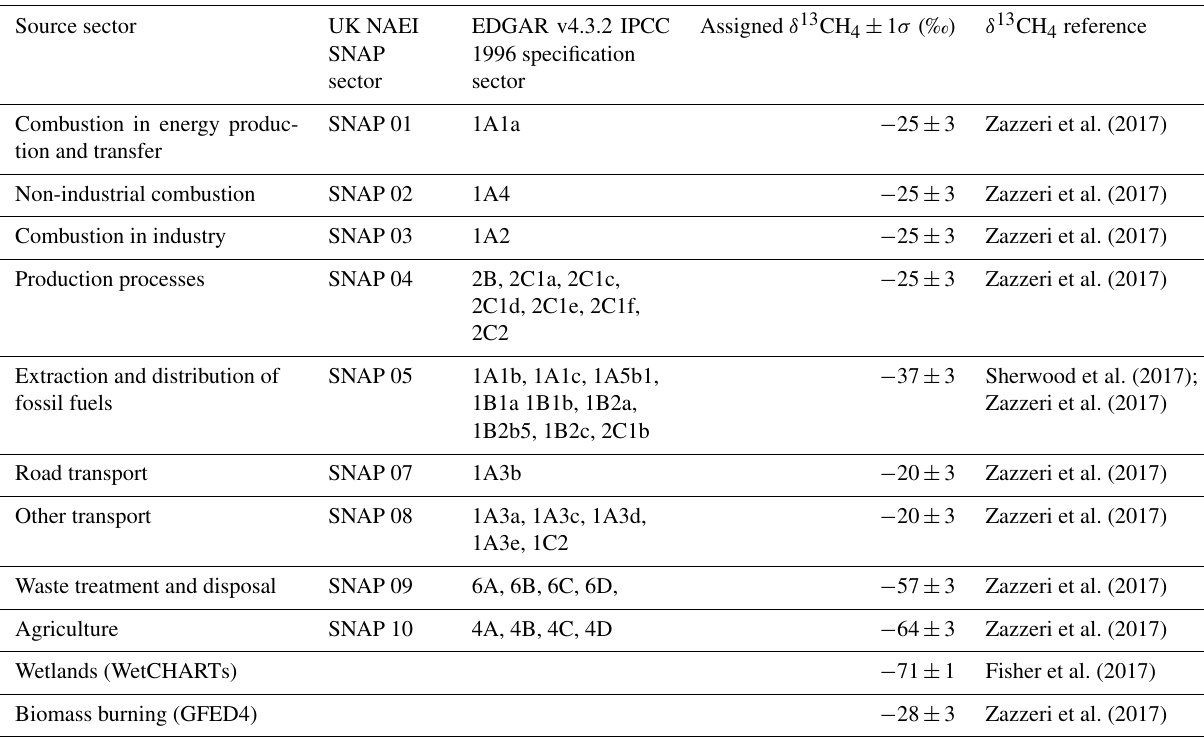
Table 3. The correspondence and allocation of methane sources between NAEI and EDGAR along with the assigned δ 13 CH 4 value for each source